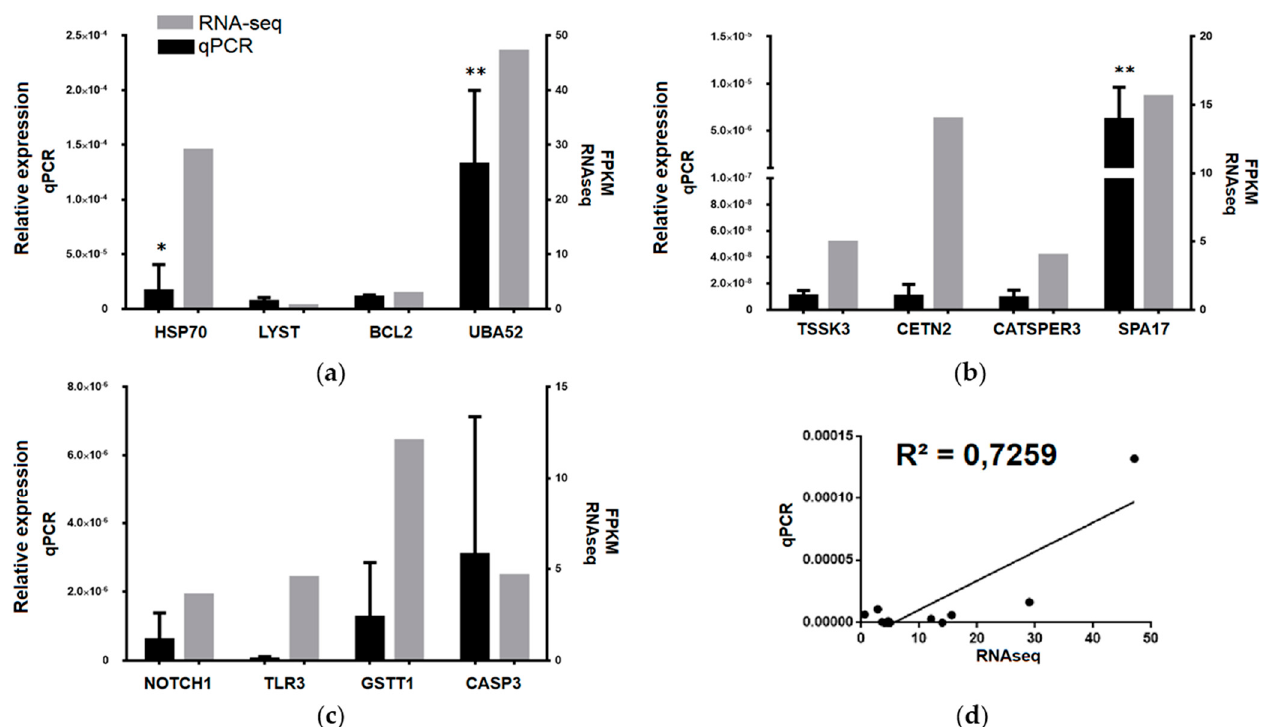
Figure 9. The quantitative real-time PCR validation of differentially expressed transcripts was highly correlated to RNA-seq. ( a ) coelomocyte; ( b ) gonad; ( c ) intestine; and ( d ) statistical correlation analysis. Expression fold changes measured by RT-qPCR and RNA-seq are indicated by black and gray columns, respectively. Abbreviations: heat shock protein 70 kDa 1 A (HSP70), lysosomal trafficking regulator (LYST), B-cell lymphoma 2 (BCL2), ubiquitin A-52 residue ribosomal protein fusion product 1 (UBA52), testis-specific serine/threonine-protein kinase 3 (TSSK3), centrin 2 (CETN2), cation channel sperm associated 3 (CATSPER3), sperm surface protein 17 (SPA17), notch homolog 1 (NOTCH1), toll-like receptor 3 (TLR3), glutathione s-transferase theta 1 (GSTT1), and caspase 3 (CASP3). * p < 0.05, ** p <